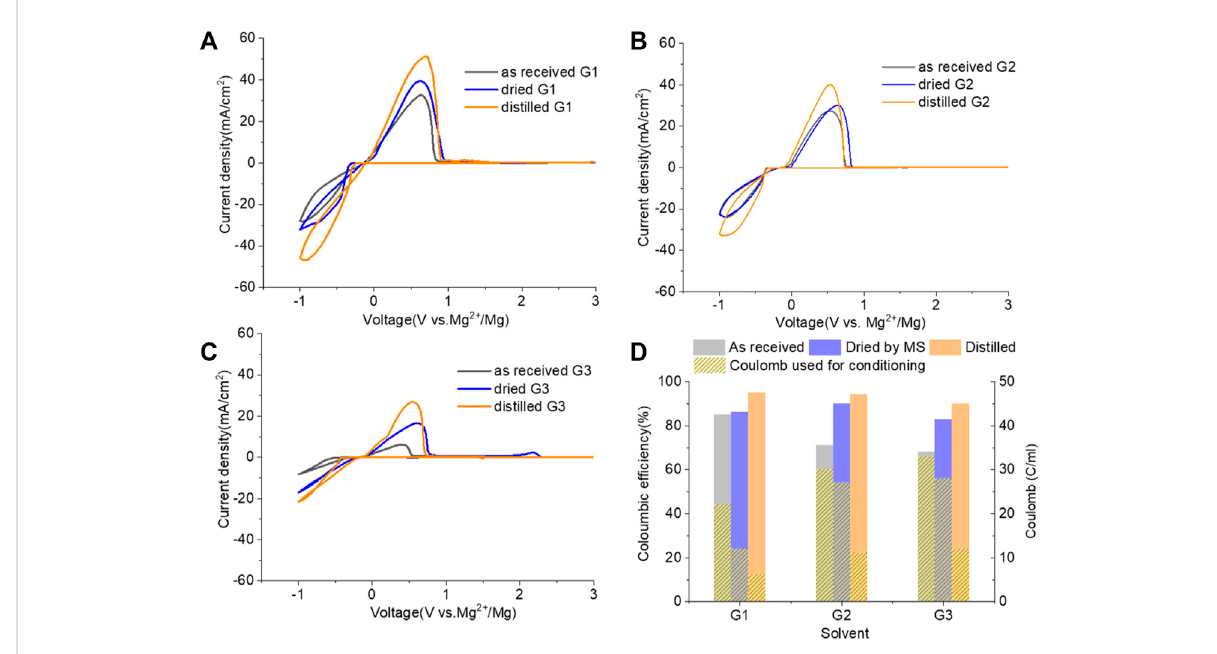
FIGURE 6 Cyclic voltammograms (CVs) for the electrolytes in (A) G,1 (B) G2, and (C) G3 (as received, dried by molecular sieves, and distilled) containing 0.25 MMgTFIS 2 and0.25 MMgCl 2 afterconditioning.Ptwasusedastheworkingelectrode,andthescanratewas25 mV s − 1 . (D) Columbicef fi ciency from CV in each used solvent after conditioning. The fi lled pattern indicates the total charge used for conditioning to eliminate impurities and optimize the reversibility of Mg